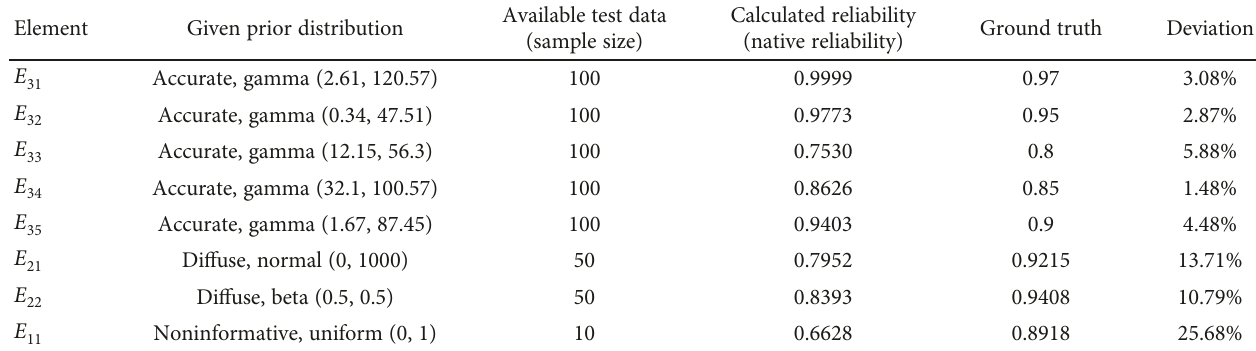
Table 7: Reliability estimation after single-element information